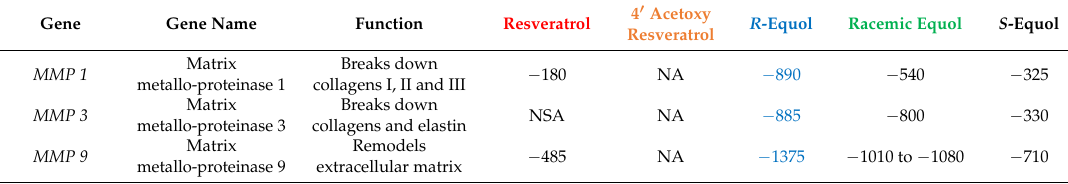
Table 5. Human skin matrix metalloproteinases (MMP) gene expression among resveratrol, 4 (cid:48) acetoxy resveratrol, R -equol, racemic equol or S -equol as the percentage of the decrease ( − ) compared to